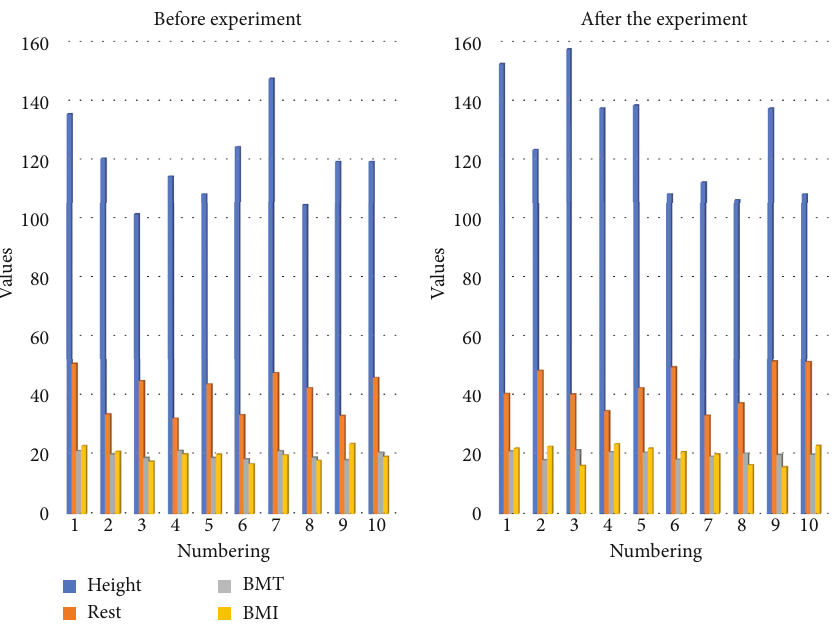
Figure 6: Statistics of height, weight, and BMI of children with autism before and after the experiment.